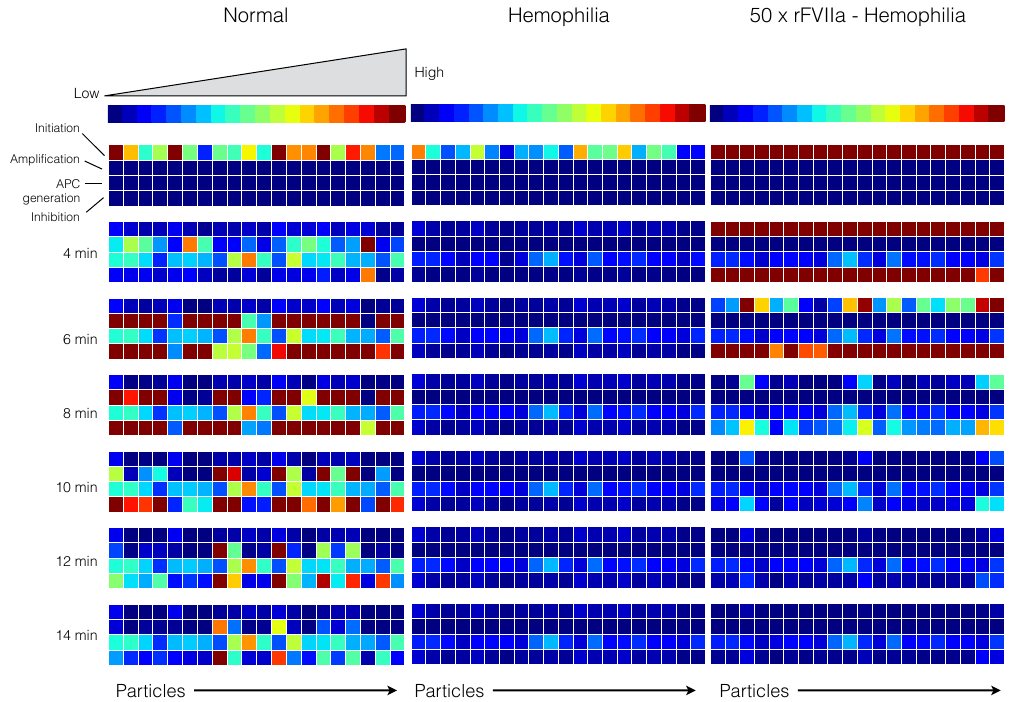
Figure 8. Reaction flux distribution as a function of time for thrombin generation under normal (left), hemophilia (center) and rFVIIa treated hemophilia (right). Reaction flux was calculated for each particle at T = 0 , 4 , 6 , 8 , 10 , 12 , 14 min after the initiation of coagulation. Reaction fluxes were calculated for each particle in the parameter ensemble ( N = 20). Blue colors denote low flux values while red colors denote high flux